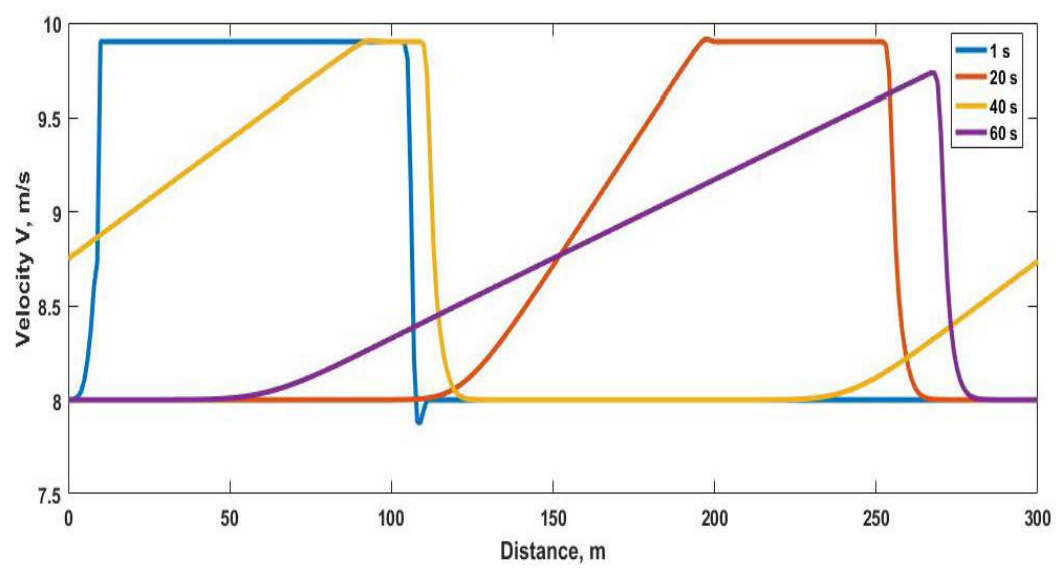
Figure 2. Velocity with the proposed model on a 300 m circular road with h = 20 m at 1 s, 20 s, 40 s and 60